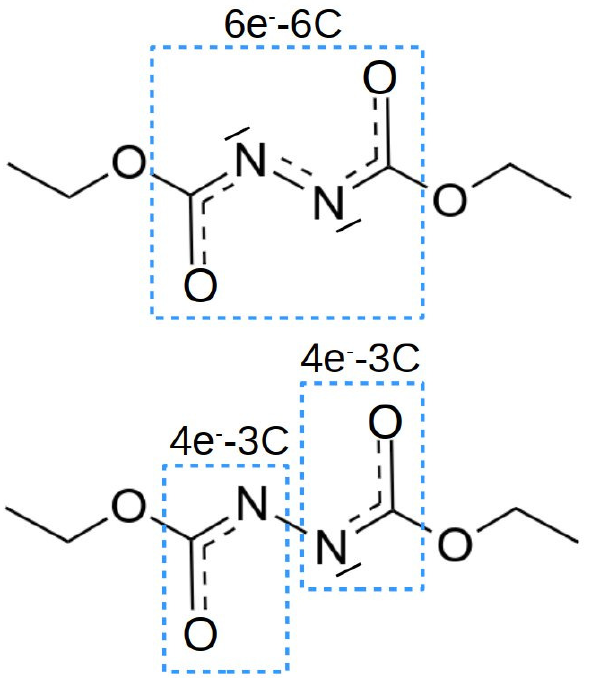
Figure 4. Electronic Lewis structure of the DEAD molecule isolated (top) and after complexation with the FLP